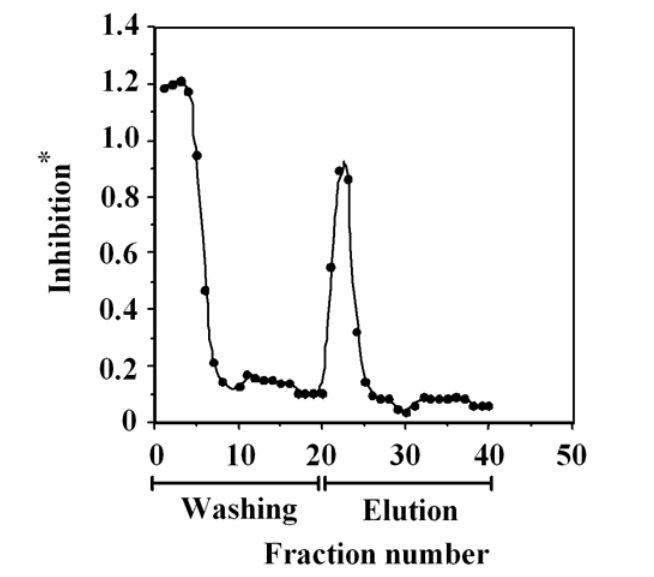
1 concentration in each fraction was 1 mAb.  Inhibition = (A − A)/A ; A is 1 0 0 0